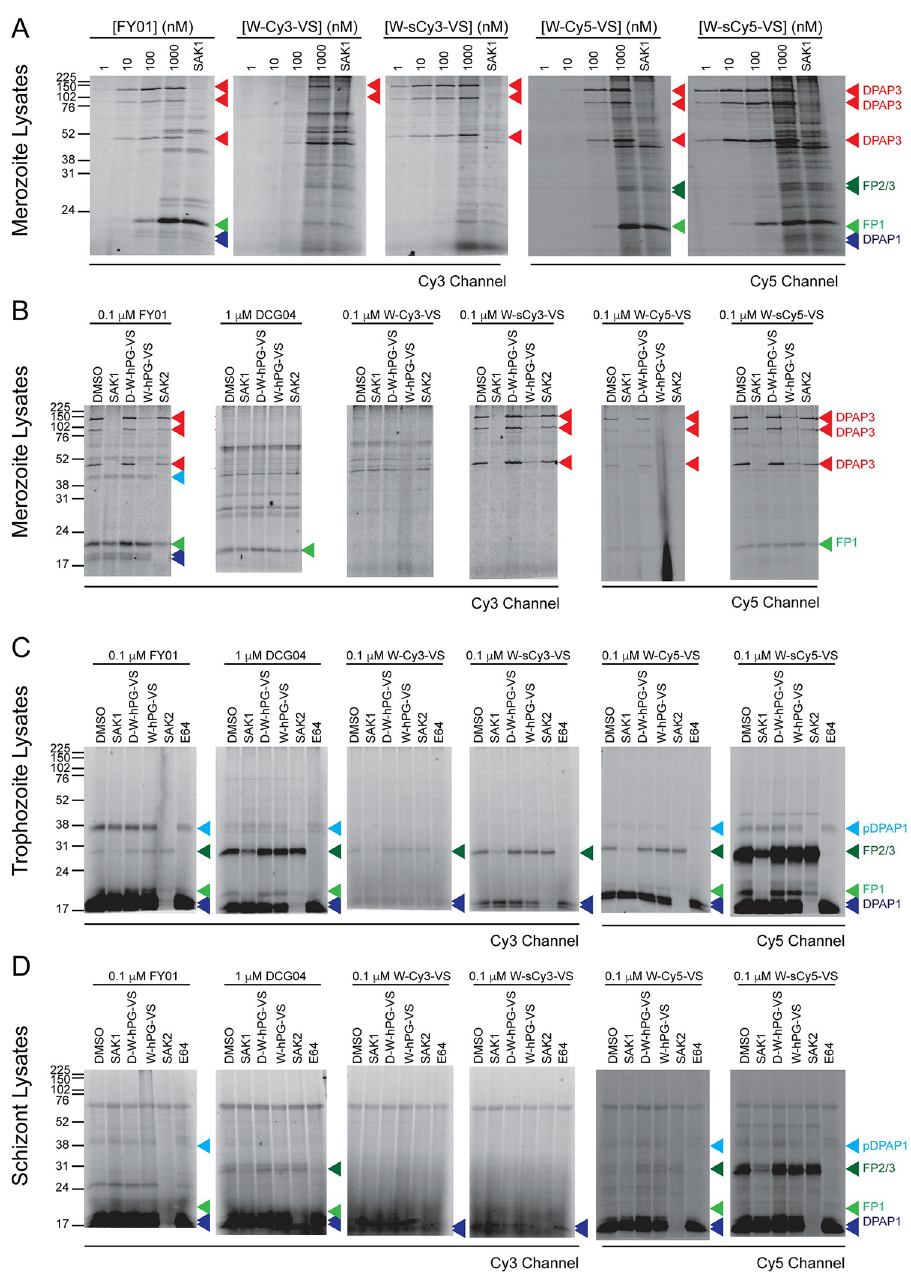
Fig 2. Labelling of cysteine proteases in parasite lysates. ( A ) Merozoite lysates diluted 1:10 in acetate buffer were treated for 1 h with 1–1000 nM of the indicated ABPs. For the highest ABP concentration, samples were also pre- treated for 30 min with 1 μ M of the DPAP3 inhibitor SAK1, which results in the loss of labelling of the three isoforms of DPAP3 running at 120, 95, and 42 kDa. ( B-D ) Lysates collected at merozoite ( B ), trophozoite ( C ), or schizont ( D ) stages were diluted in acetate buffer (pH 5.5), pre-treated for 30 min with DMSO or 10 μ M of different known covalent inhibitors of DPAP1 (SAK2), DPAP3 (SAK1 or W-hPG-VS), the FPs (E64), or the negative control compound D -W- hPG-VS. This was followed by 1 h labelling with the different ABPs at 0.1 μ M except for DCG04 that was used at 1 μ M concentration. ( A-D ) The fluorescent bands corresponding to DPAP1, DPAP3, FP1, and FP2/3 are indicated by blue, red, light green, and dark green arrowheads, respectively. Two additional biological replicates of these experiments are shown in S3 Fig.